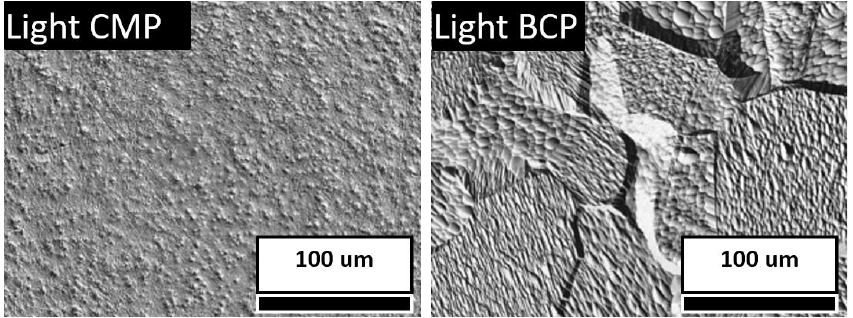
Figure 8. Optical images acquired by laser confocal microscope after step 1 followed by a 15-min CMP polishing ( left ), and after a 10-min BCP etching ( right ).